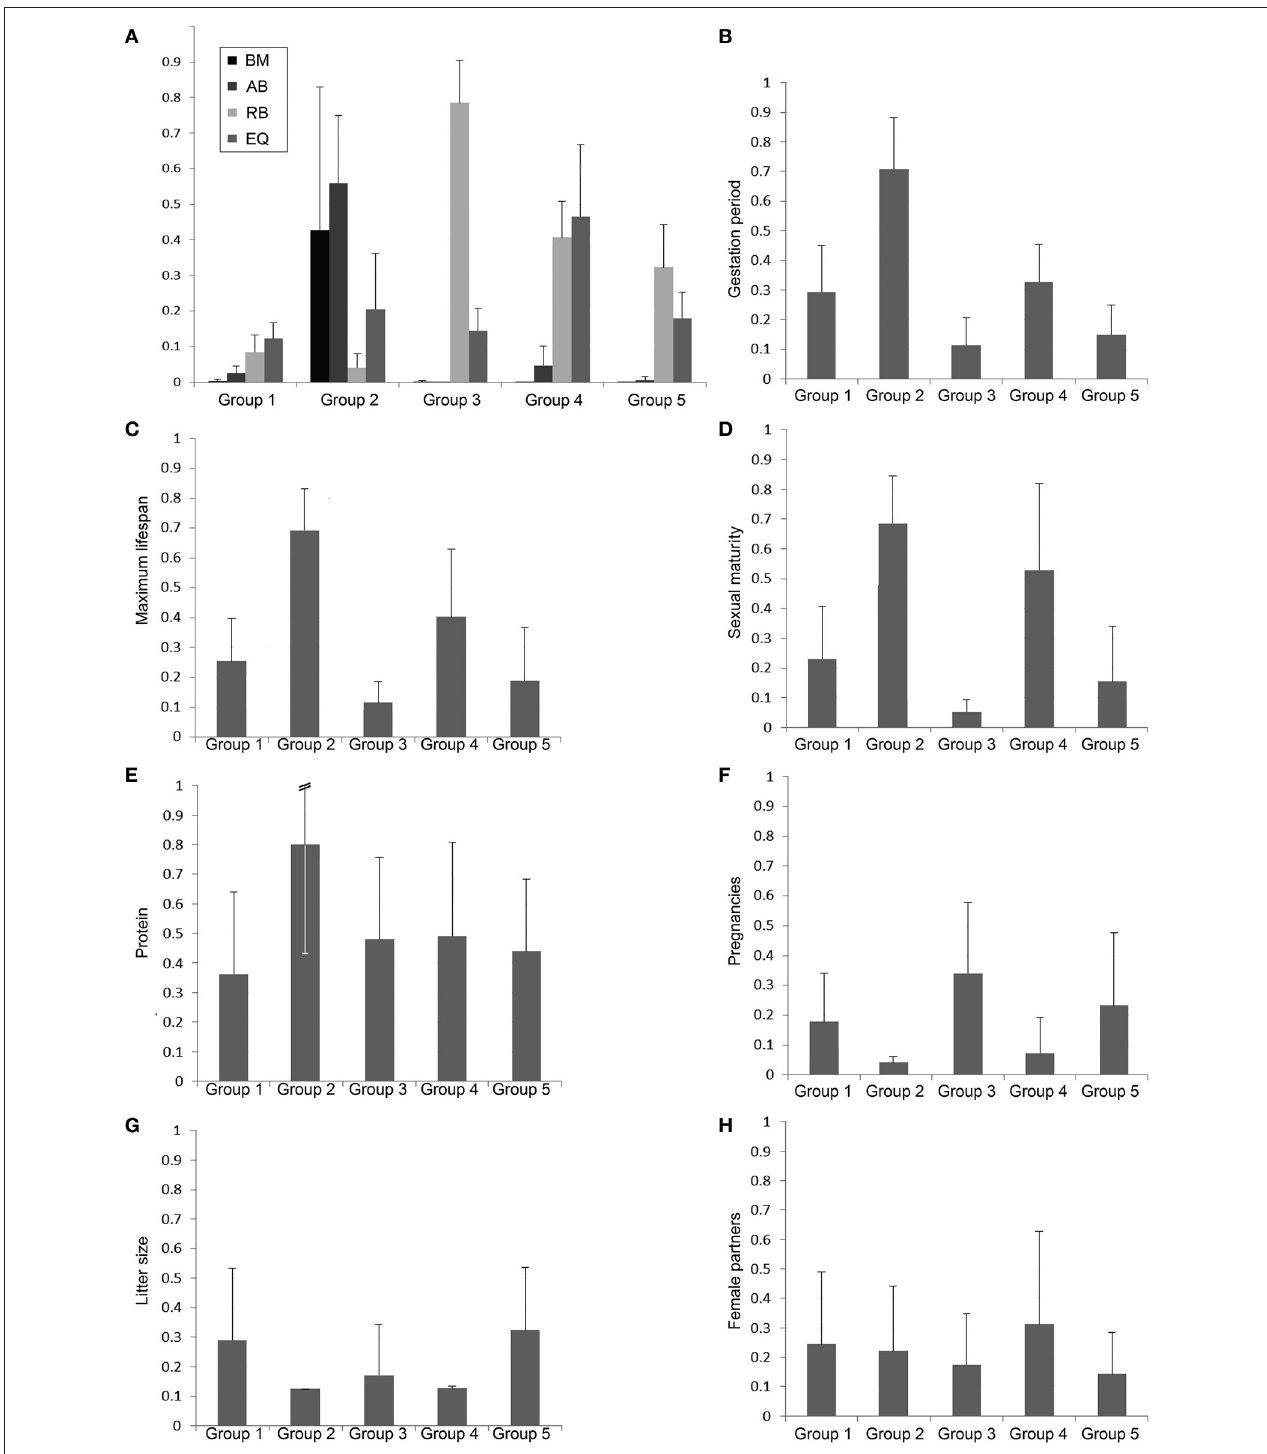
FIGURE 4 | Bar charts of normalized group mean values and standard deviations of the body mass (BM), absolute brain mass (AB), the relative brain mass (RB), and the EQ (A) as well as the biological parameters with potential discriminatory impact of the groups 1–5 defined by the cluster analysis